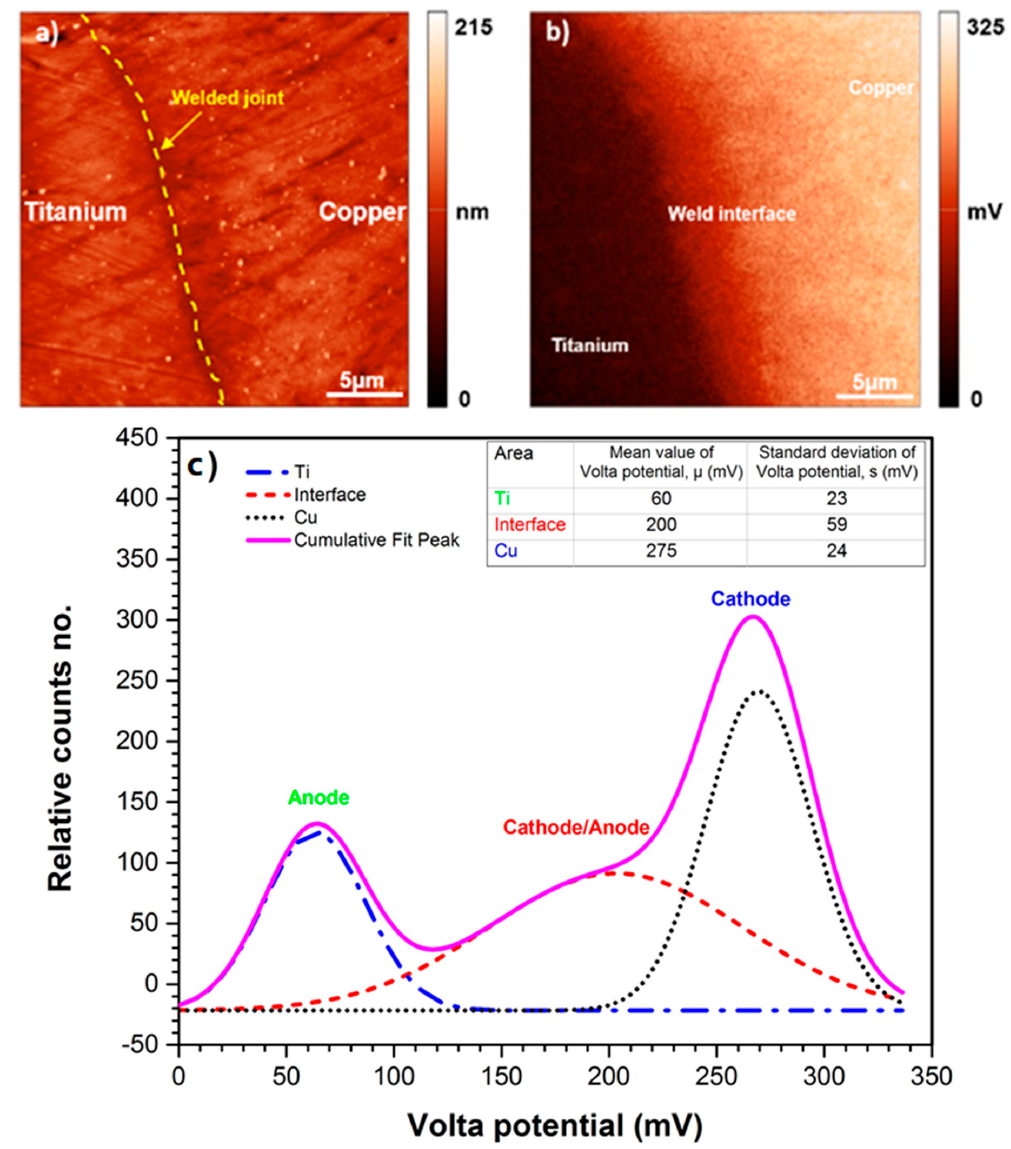
Figure 15. ( a ) AFM and ( b ) SKPFM image of Ti/Cu weld interface before immersion, ( c ) histogram analysis of Volta potential map obtained from ( b ); high Volta potential difference could be a reason for galvanic corrosion between Ti and Cu matrices.